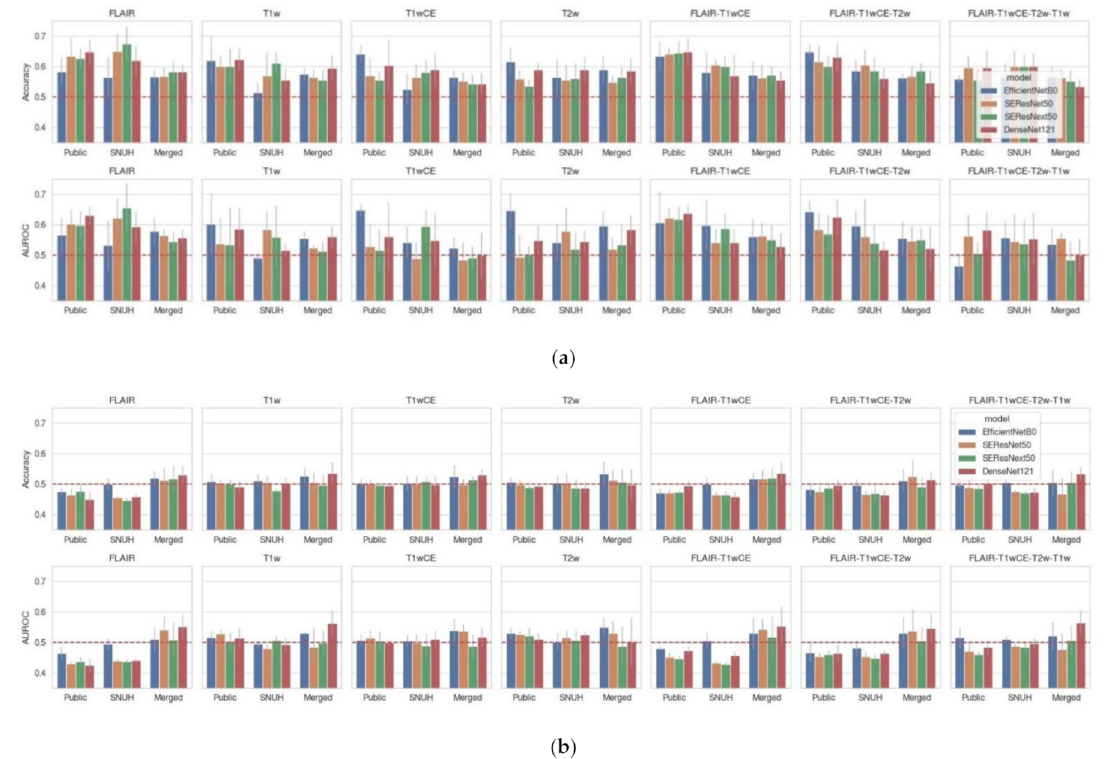
Figure 2. Model performance in the ( a ) validation (or tuning) and ( b ) test sets. For each of the experi- ments, both accuracy and AUROC are shown to report the model performance in the ( a ) validation (i.e., tuning) and ( b ) test sets. Note that the dashed red lines are the chance level (50%). The horizontal axis is the dataset on which the model was trained/validated (i.e., trained/tuned): “Public” indicates that the model was trained/validated on the BraTS dataset and tested on the SNUH dataset. “SNUH” indicates that the model was trained/validated on the SNUH dataset and tested on the BraTS dataset. “Merged” indicates that the model was trained/validated and tested with a randomly split SNUH + BraTS dataset. Error bars indicate the standard deviation of the metrics. Note that the validation metrics are better than the test metrics because the model training was stopped early according to the high validation accuracy. The red dotted lines indicate the chance level. Abbreviations: AUROC, area under the receiver operating characteristic